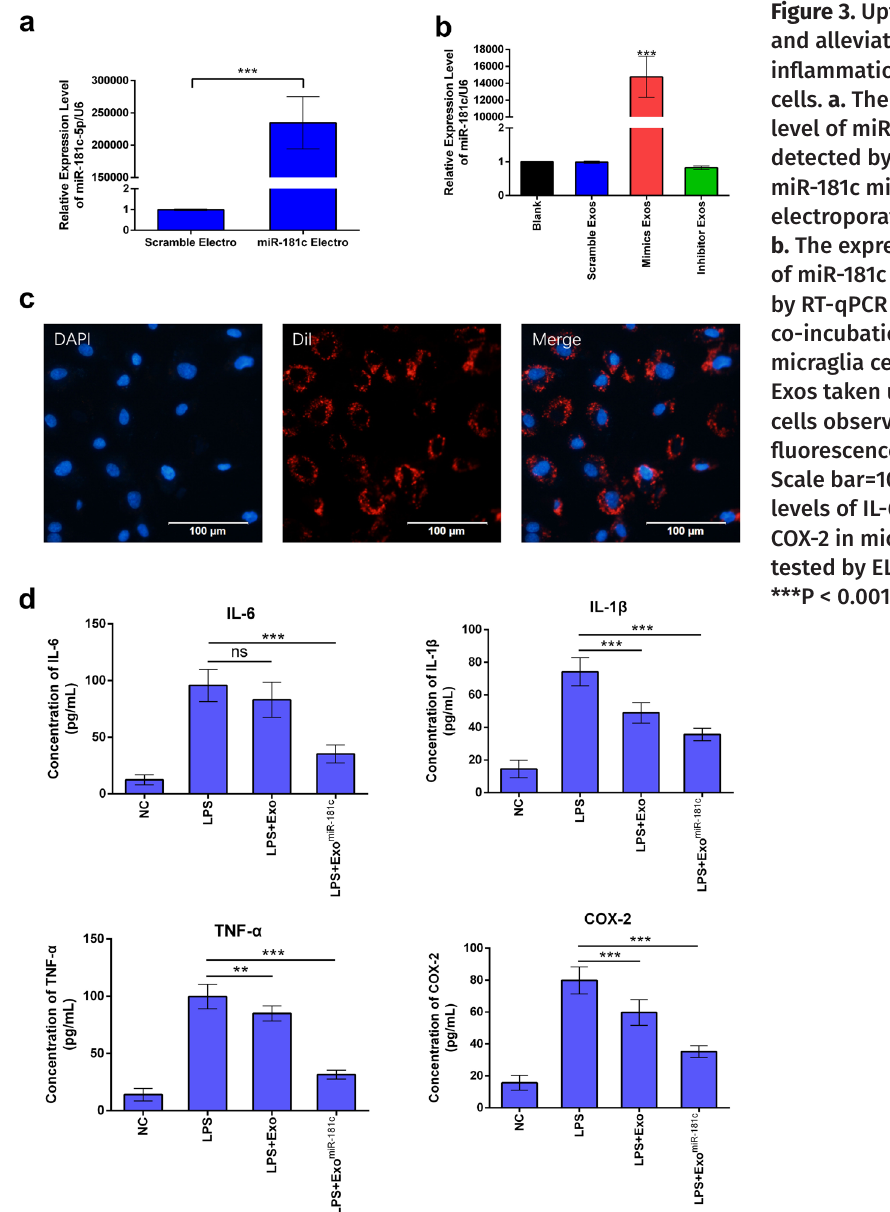
Figure 3. Uptake of Exos and alleviates LPS-induced inflammation in microglia cells. a. The expression level of miR-181c was detected by RT-qPCR after miR-181c mimics, inhibitor electroporation in Exos. b. The expression level of miR-181c was detected by RT-qPCR after Exos co-incubation for 6 h in micraglia cells. c. DiI-labelled Exos taken up by microglia cells observed under fluorescence microscope. Scale bar=100μm. d. Protein levels of IL-6, IL-1β, TNFα and COX-2 in microglial cells were tested by ELISA. **P < 0.01 , ***P < 0.001 vs . LPS